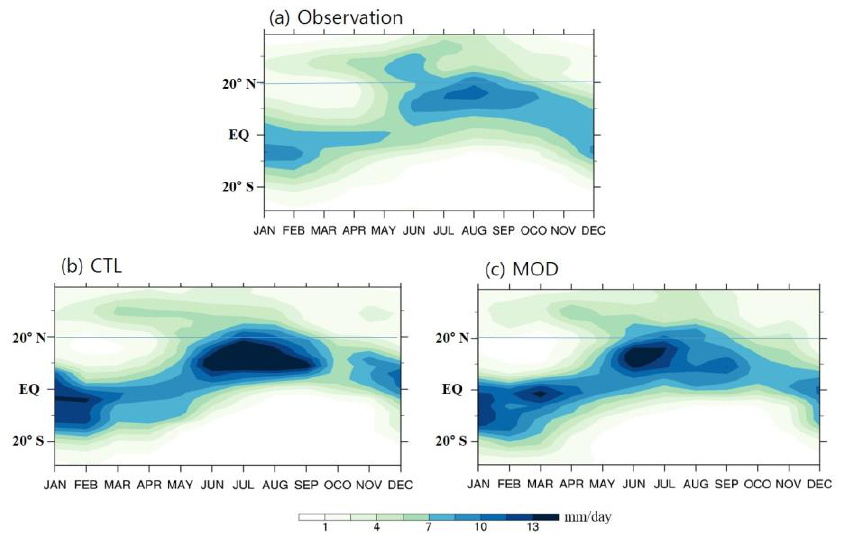
Figure 8. Annual cycle climatology (1980–2009) for pentad mean precipitation averaged between 110° E and 130° E from: ( a ) observation; ( b ) CTL; and ( c ) MOD. The blue horizontal line shows 20° N.